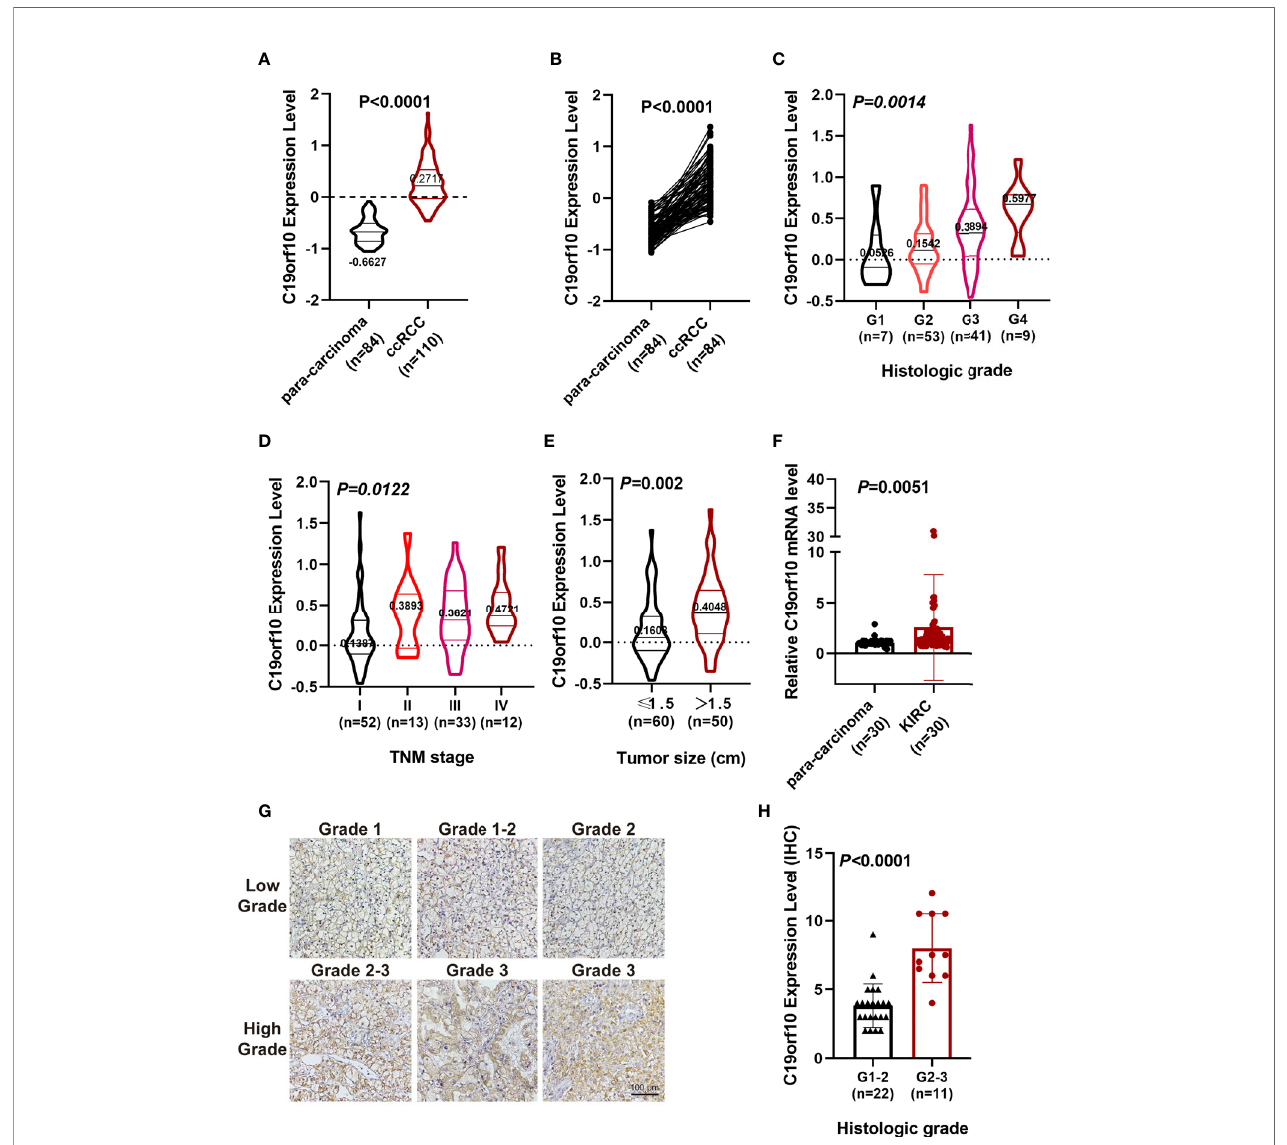
FIGURE 2 | C19orf10 protein up-regulated in CPTAC database and associates with KIRC clinical pathology. (A) C19orf10 protein expression in KIRC in CPTAC dataset. (B) C19orf10 protein expression in 84 paired KIRC in CPTAC dataset. (C – E) Relative protein expression level of C19orf10 in CPTAC dataset with differential histologic grade (C) , TNM stage (D) and tumor size (E) . (F) C19orf10 expression in 30 paired KIRC samples by qPCR detection, n=30. (G) Representative immunohistochemical images of C19orf10 in differential histologic grade in KIRC tissues. Scale bar, 100 m m. (H) Elevated C19orf10 expression in high grade KIRC tissues (grade 2-3, grade 3) compared with low grade ones (grade 1, grade 1-2 and grade 2). The numbers of samples are indicated in fi gures, Mean ± SD is shown. P values are calculated by Student ’ s t-test or one-way ANOVA and indicated in fi